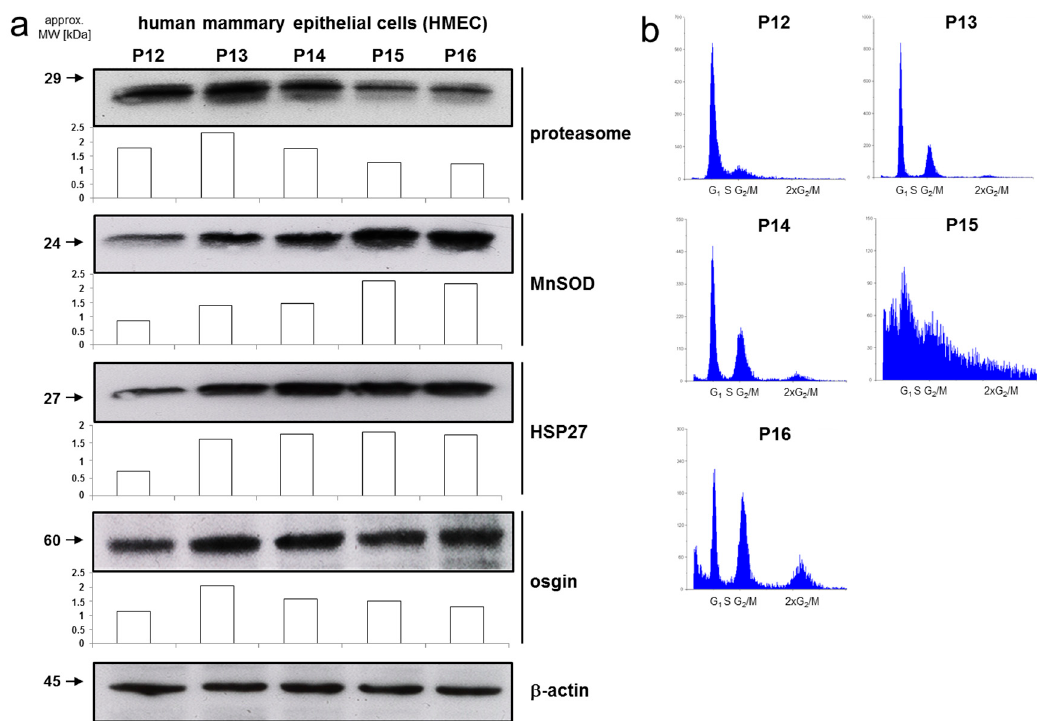
Figure 3. Characterization of the senescent phenotype of HMEC between P12 and P16. ( a ) HMEC of different passage numbers were lysed and subjected to immunoblot analysis of the indicated proteins. Detection of β -actin served as loading control. Intensities were quantified by NIH Image J with corresponding ® -actin protein bands as a reference; ( b ) Cell cycle distribution in HMEC of different passage numbers.